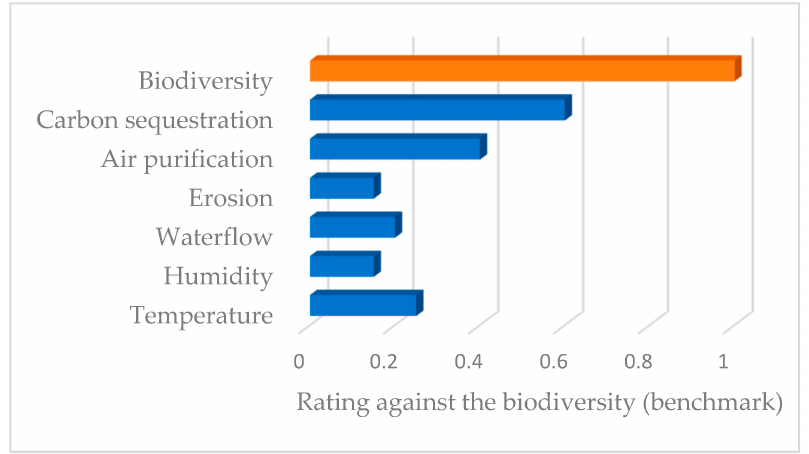
Figure 3. The weighting of non-provisioning ecosystem services with biodiversity as a benchmark (adapted from Krzemie ń et al. [1]).